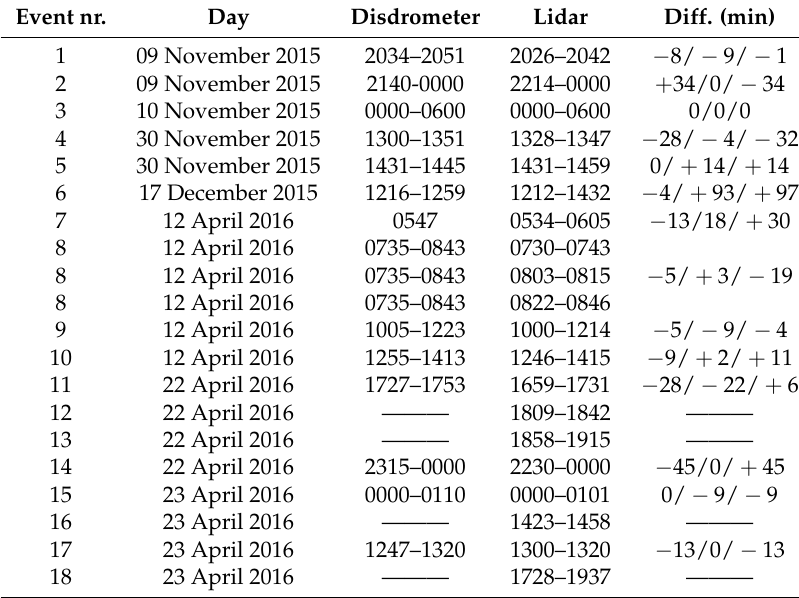
Table 1. Precipitation events observed by Parsivel 2 at NASA GSFC used to validate the rain detection algorithm. The three values reported in the fifth column are the differences in minutes between disdrometer and algorithm in detecting precipitation. The first value represents the difference in minutes with respect to the precipitation start, the second one the same but for the precipitation end, while the third represents the difference in minutes on overall precipitation duration. Event nr. Day Disdrometer Lidar Diff.